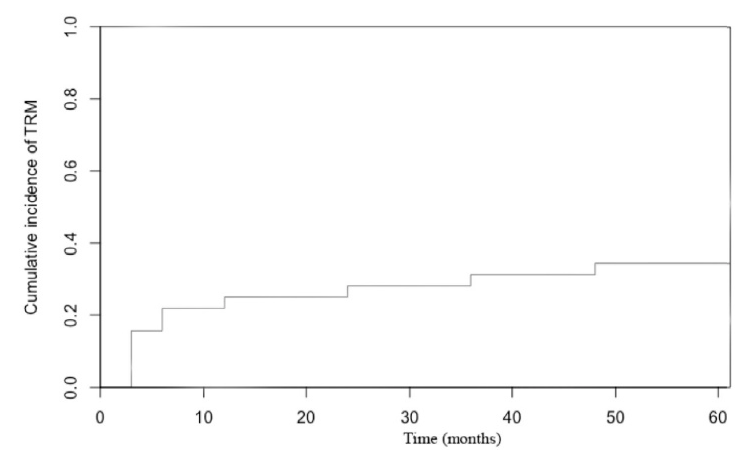
Figure 1. Cumulative incidence of treatment related mortality.